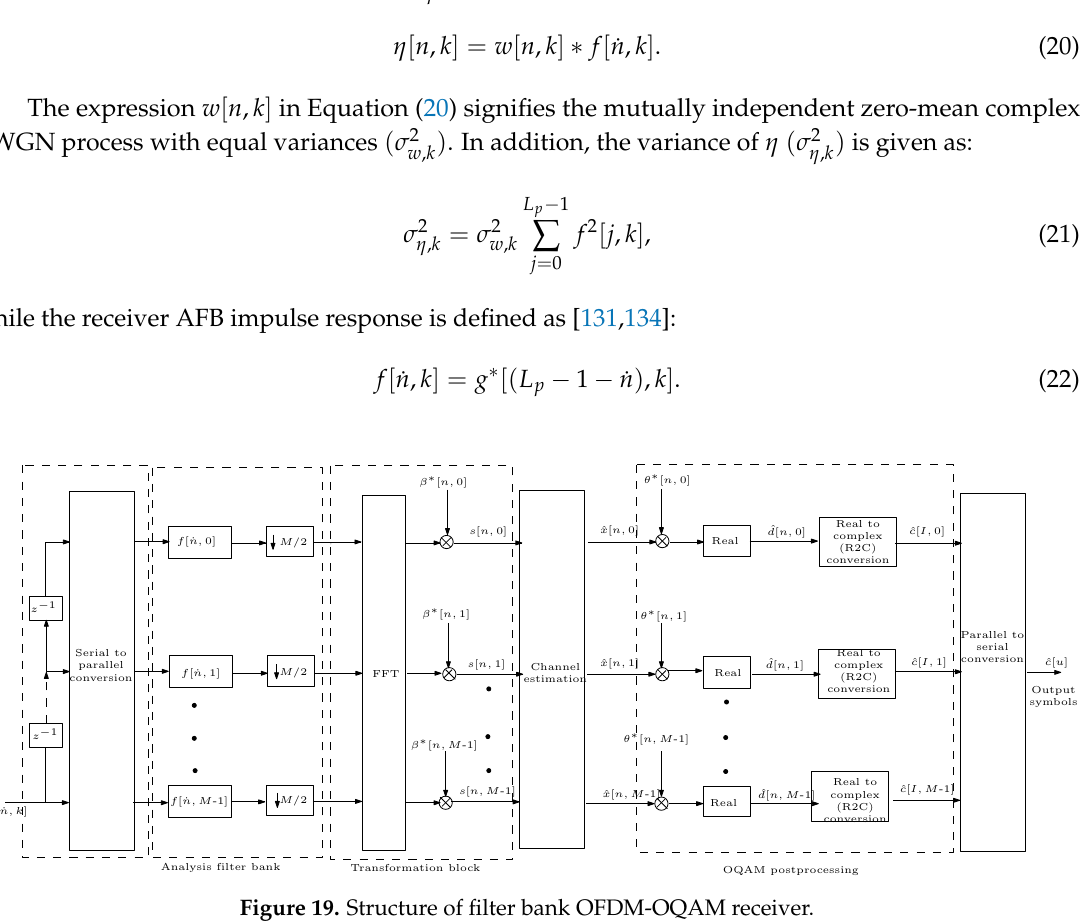
Figure 19. Structure of filter bank OFDM-OQAM